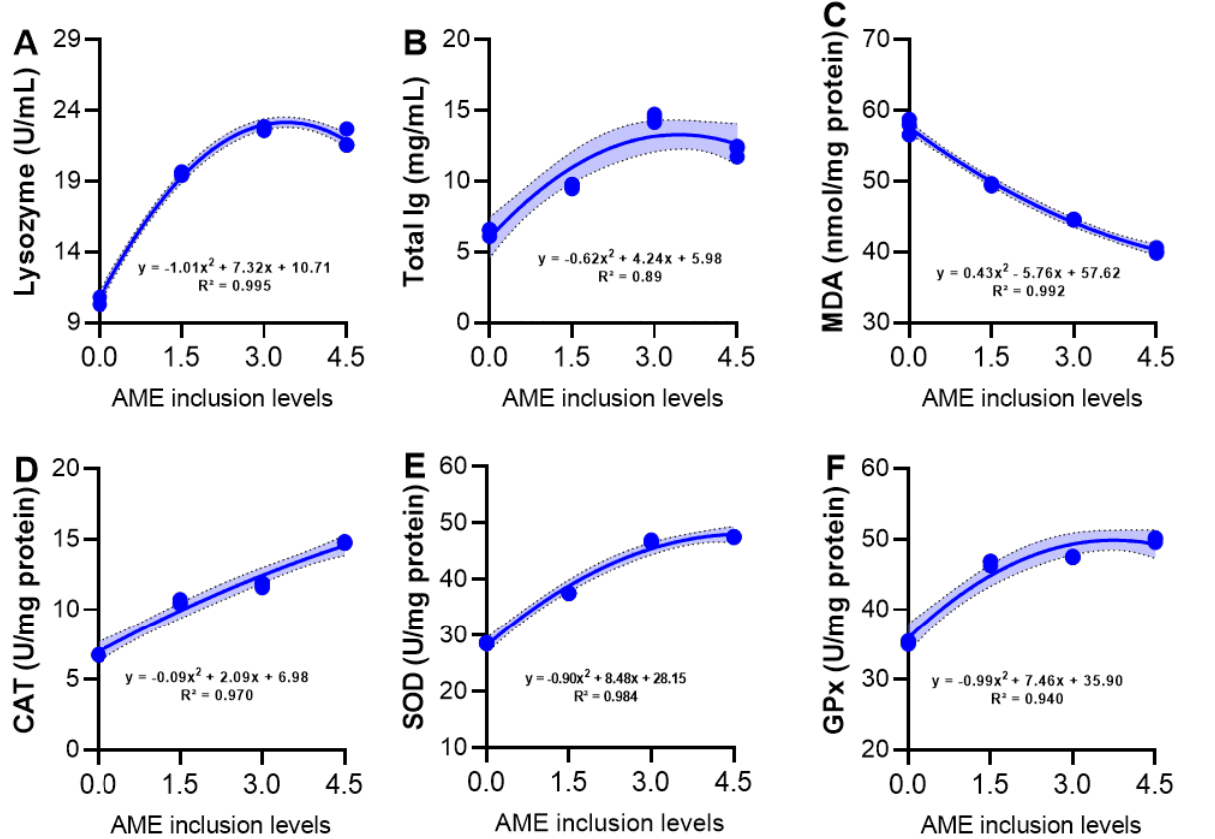
Figure 4. Serum immune responses (lysozyme and total Ig) ( A , B ) and hepatic antioxidant activity ( C – F ) of juvenile P. hypophthalmus fed diets with different AME inclusion levels over the feeding trial period of 56 days. Data lines denote best fit models for the data. Equations and R square in the figures demonstrate the relationship between the measured parameters and AME inclusion levels. Individual marker indicates the number of technical replicates (n = 3). Individual marker is the mean of two biological replicates.